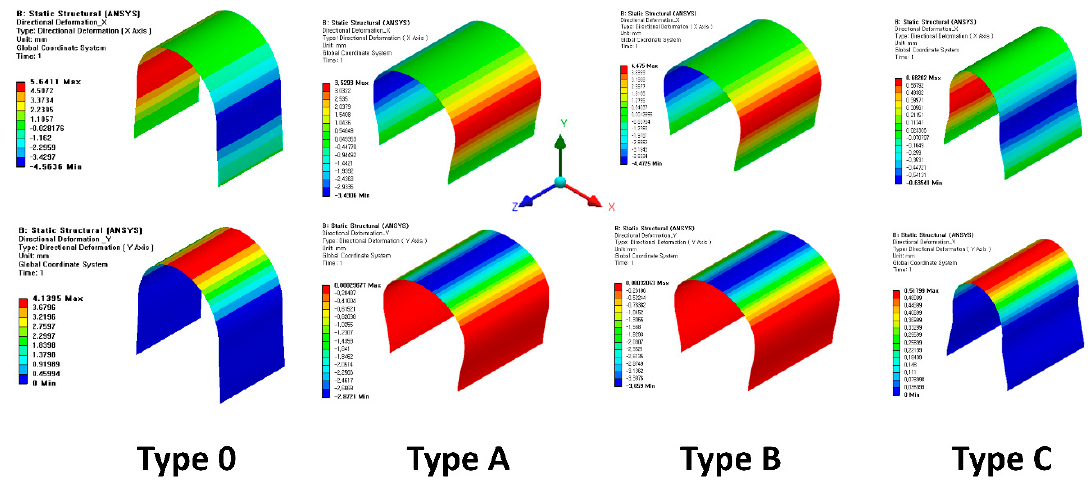
Figure5. Deformationofthefloatingsubstrateinducedbythecalculatedpneumaticpressure. Theupper and lower rows indicate the deformations along the x -axis and y -axis, respectively. Appl. Sci. 2020 , 10 , x FOR PEER REVIEW